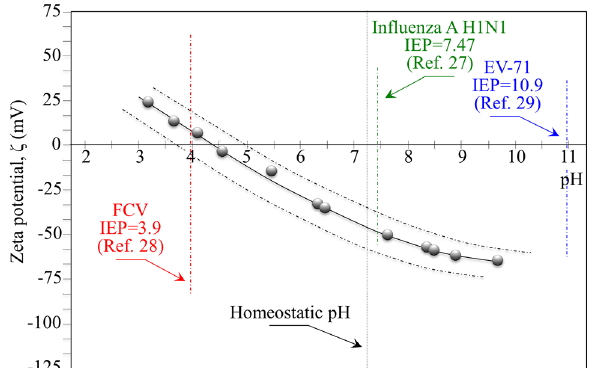
Figure 3. Results of zeta potential, ζ, measurements on the Si 3 N 4 powder and its IEP value compared to the IEPs of the investigated viral strains as obtained from literature (cf. labels in inset).